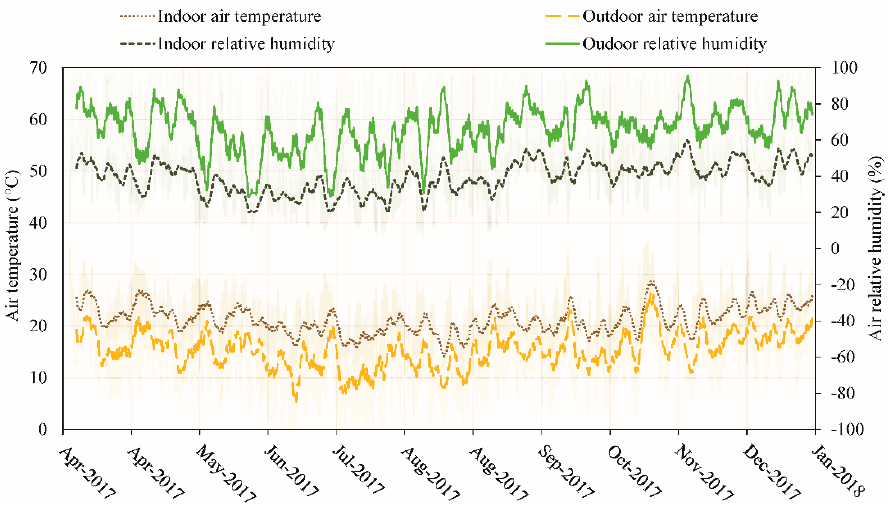
Figure 6. Average indoor and outdoor air temperature and relative humidity distribution.